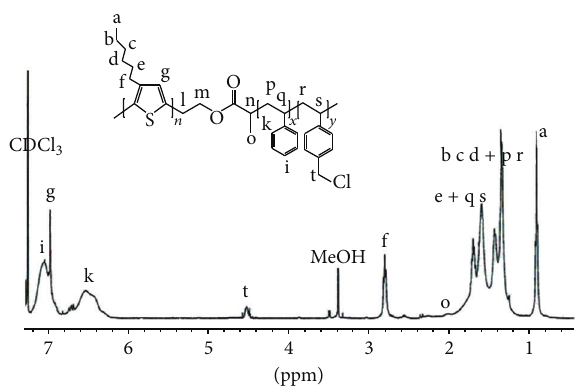
Figure 5: 1 H-NMR spectrum of the P3HT- b -P(S- co -CMS).